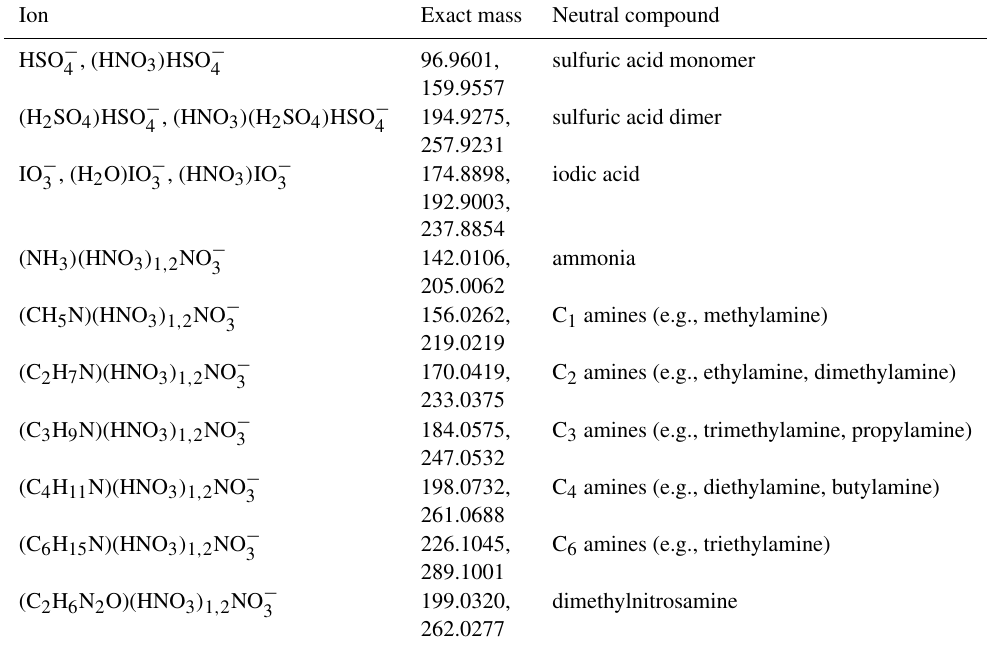
Table 1. List of ions used in the identification of sulfuric acid (monomer and dimer), iodic acid, ammonia, amines (C 1 , C 2 , C 3 , C 4 and C 6 ) and dimethylnitrosamine. Cattle farms in the vicinity of the measurement site are expected to be a source for the listed amines (Ge et al.,